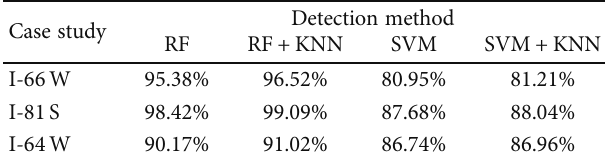
Table 7: Overall accuracy